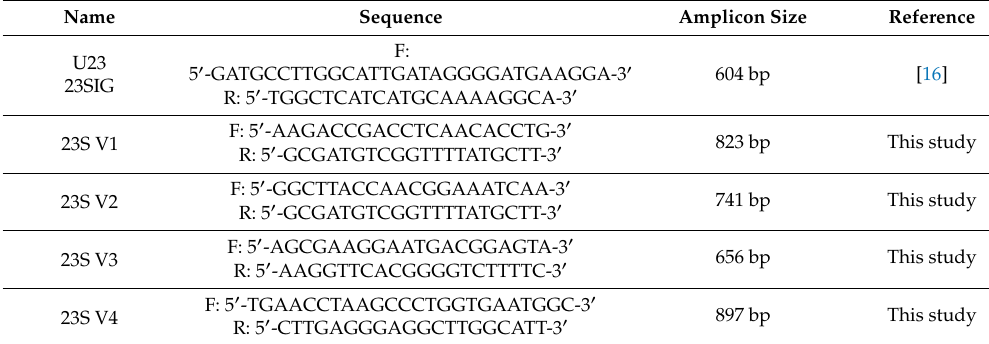
Table 1. The primers used in this study.